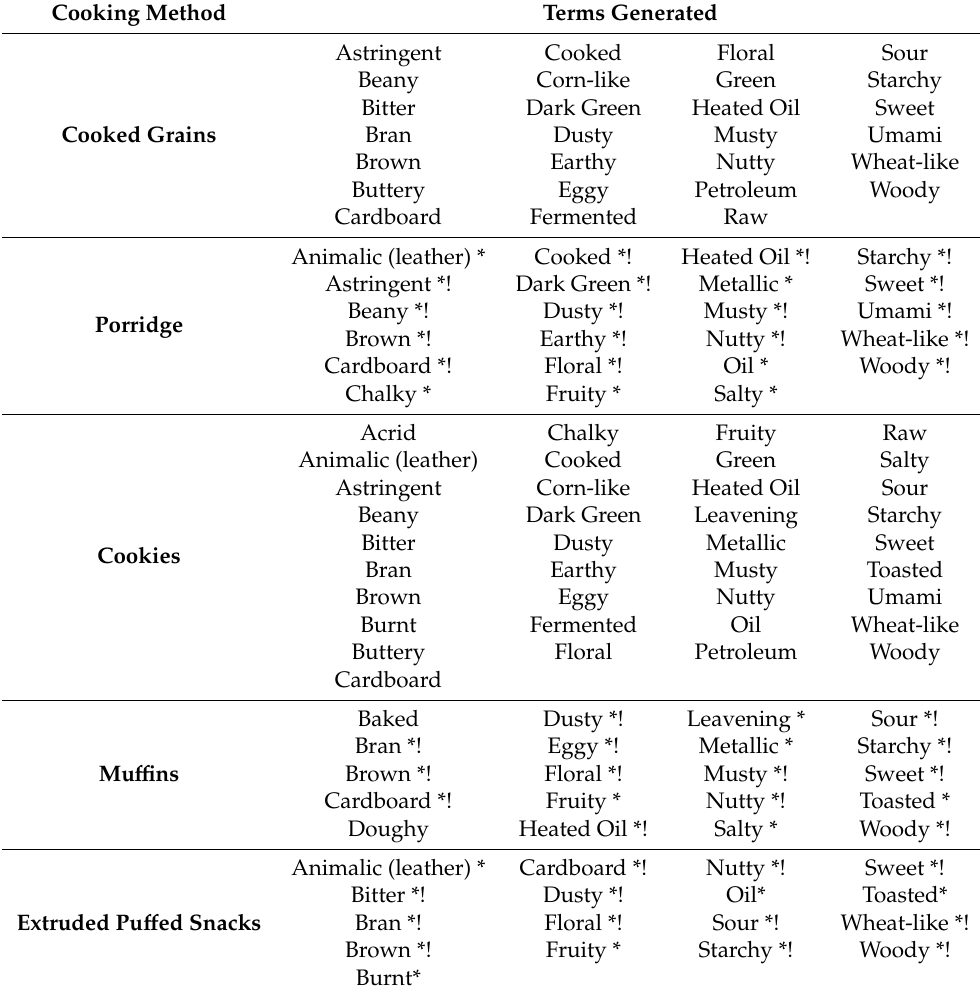
Table 5. Generated sensory terms from 5 cooking